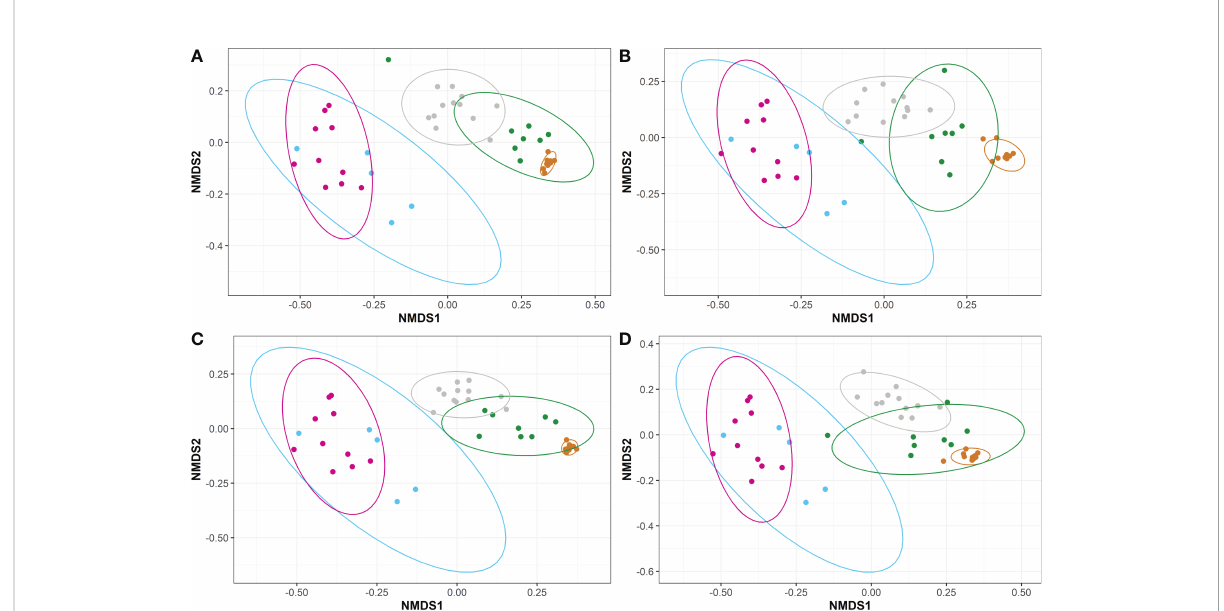
FIGURE 4 Non-metric Multidimensional Scaling (NMDS) plots representing the unweighted beta diversities of steelhead trout bacterial microbiomes for the duration of a probiotic feeding regime. Distances were calculated by unweighted UniFrac between the fi ve timepoints for fi sh fed diets (A) A, (B) B, (C) C, and (D) D. Timepoints are represented by the colors cyan (T-1), maroon (T0), orange (T1), green (T2), and gray (T3). Ellipses represent the 95% con fi dence intervals calculated via Student ’ s T test for fi ve non-disinfected eggs, 10 T0 internal homogenates, 10 T1 internal homogenates, eight T2 intestinal homogenates, and 12 T3 intestinal